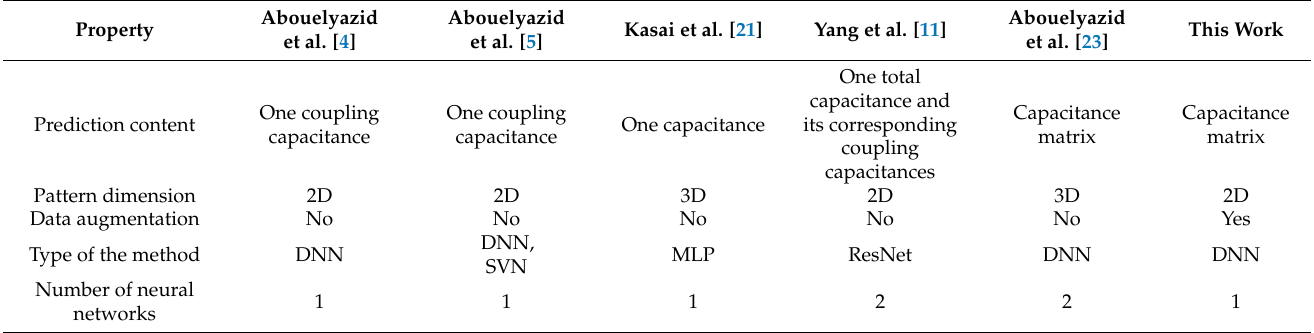
Table 1. The comparison among different capacitance extraction methods, including our